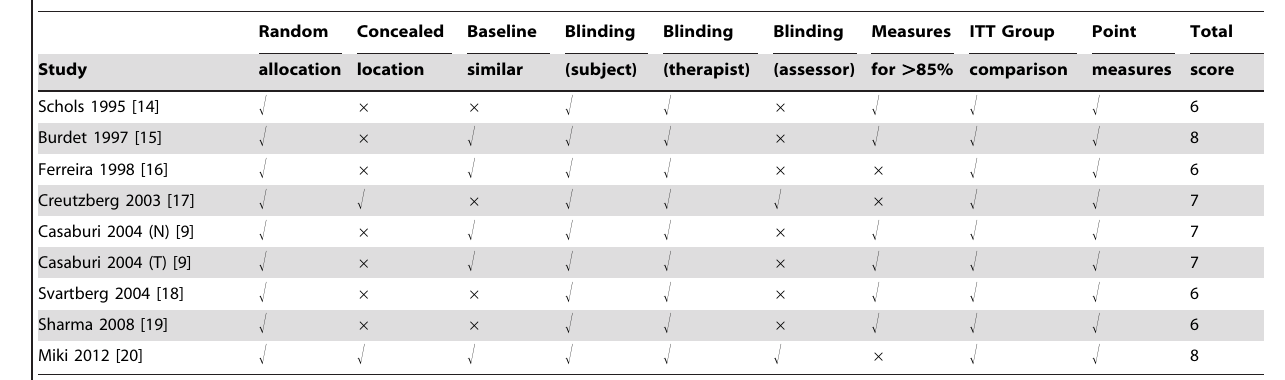
Table 3. Quality score of selected studies by the PEDro.